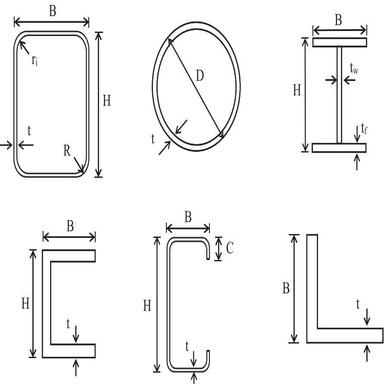
Variables on cross-section properties for different section types.